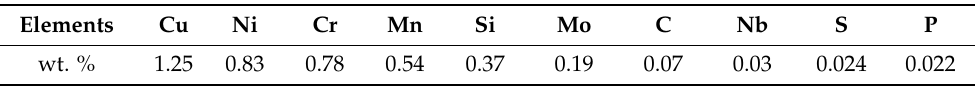
Table 1. Chemical composition of HSLA Steel, reprinted with permission from ref. [39]. Copyright 2018 Elsevier Ltd.